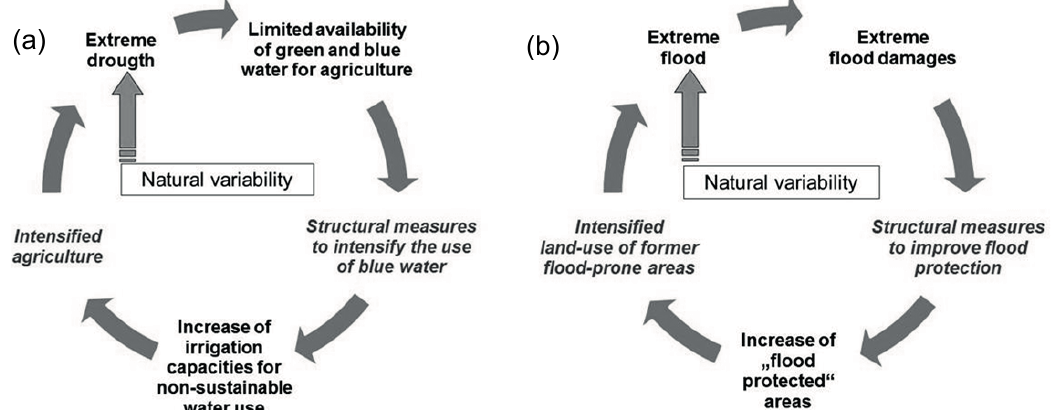
Fig. 1 Different types of feedback mechanisms between hydrological extremes and human interventions: (a) for water shortages, (b) for